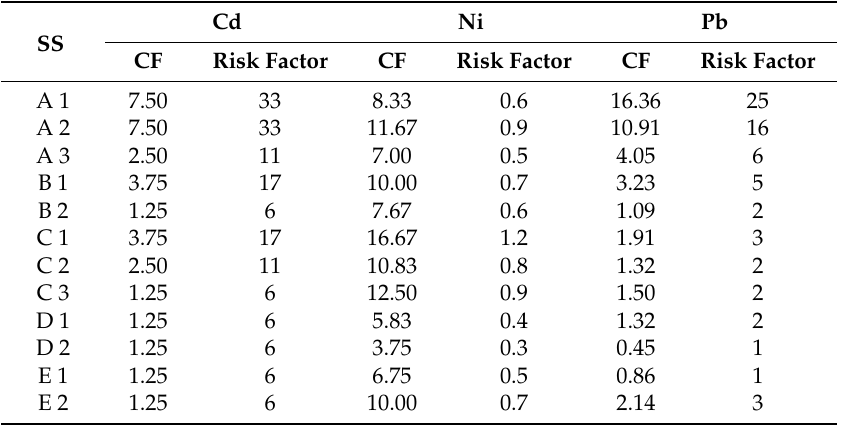
Table 3. Results of the calculation of the Contamination Factor (CF) and the Risk Factor of each element in each sampling